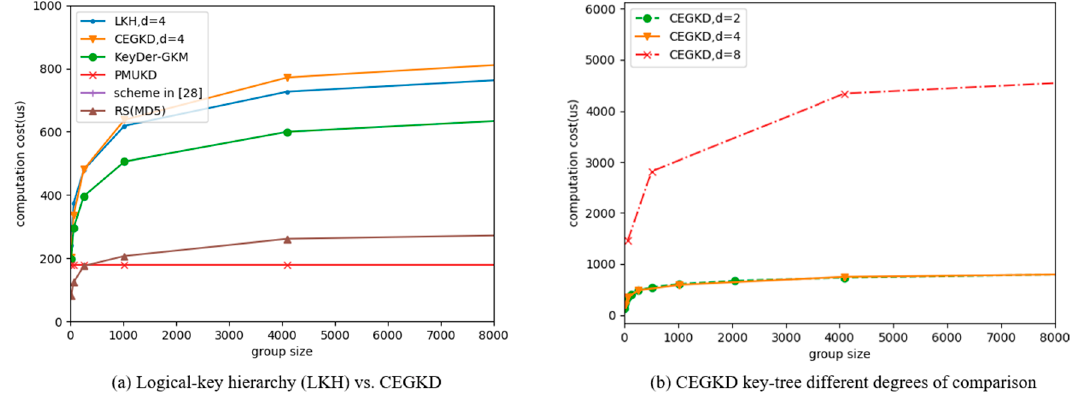
Figure 2. GC computation cost.